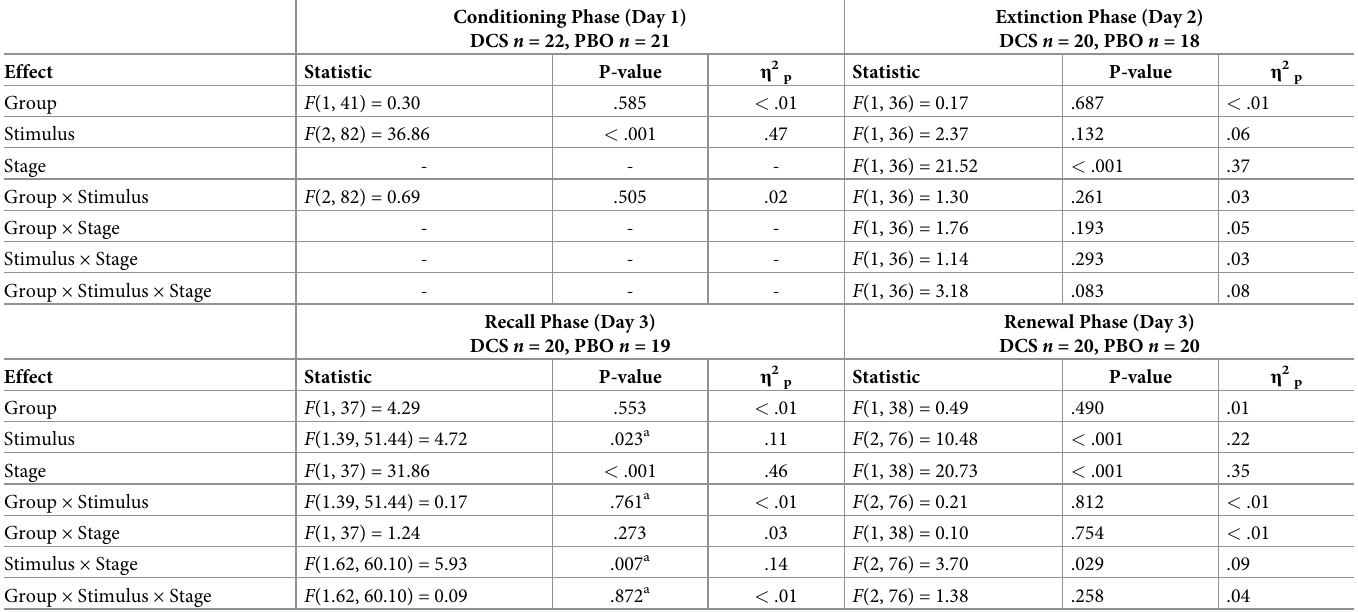
Table 1. SCR results from ANOVAs across experimental